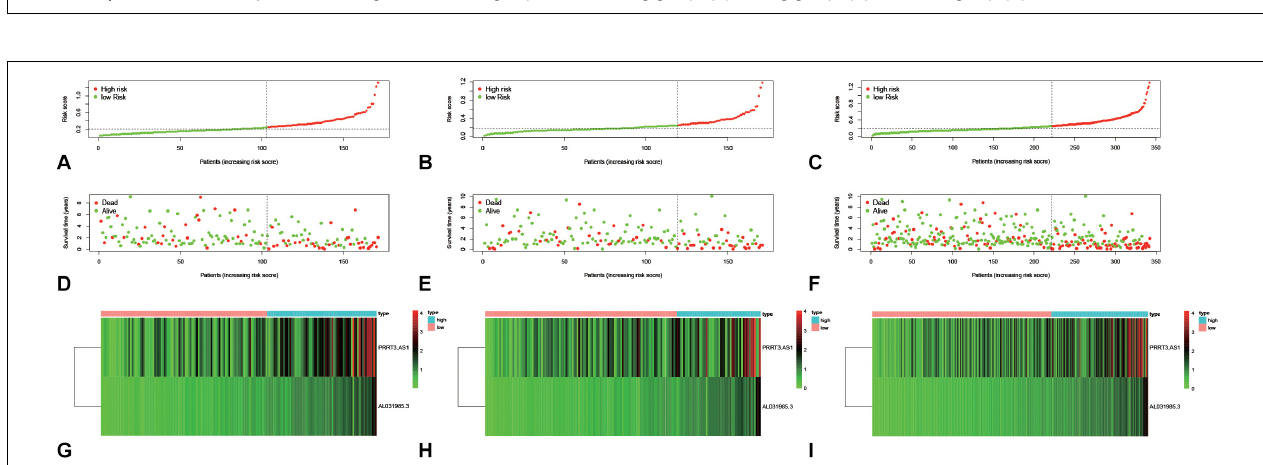
FIGURE 2 | Survival curve analysis between high and low-risk groups in the training group: (A) Testing group. (B) The entire group (C) .